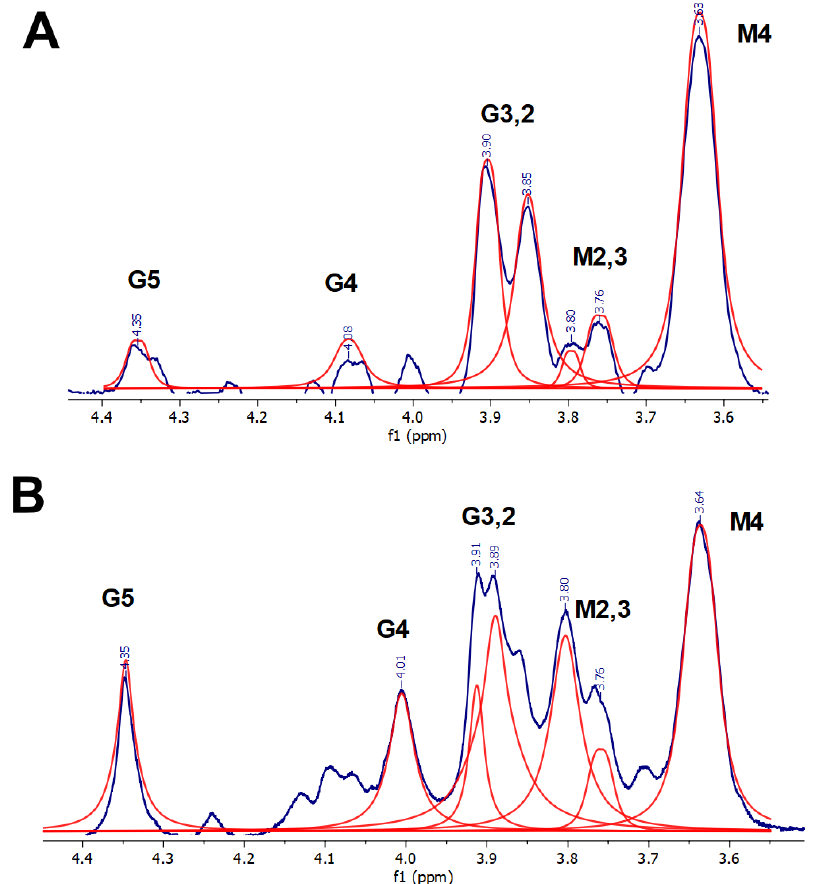
Figure 4. 1 H NMR spectra of ( A ) ALG–Sr and ( B ) ALG–Ca, cross-linked by equal quantities (0.3 μmol) of Ca 2+ and Sr 2+ ions, respectively. Fitting is represented by red lines, fitting baseline is shown at the bottom.